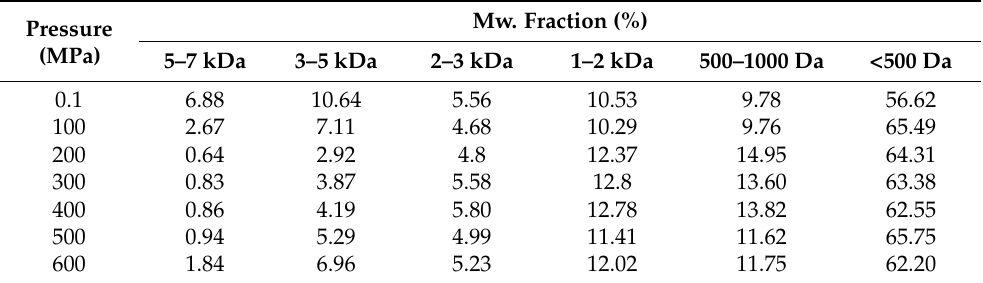
Figure 4. Conformational changes of b-LG under different pressures as revealed by molecular dynamics simulation. The structure colored gray is the initial structure of b-LG, while the rainbow-colored structures are the structure under different pressures. Table 1. Molecular weight (Mw.) profile of b-LG hydrolysates under different